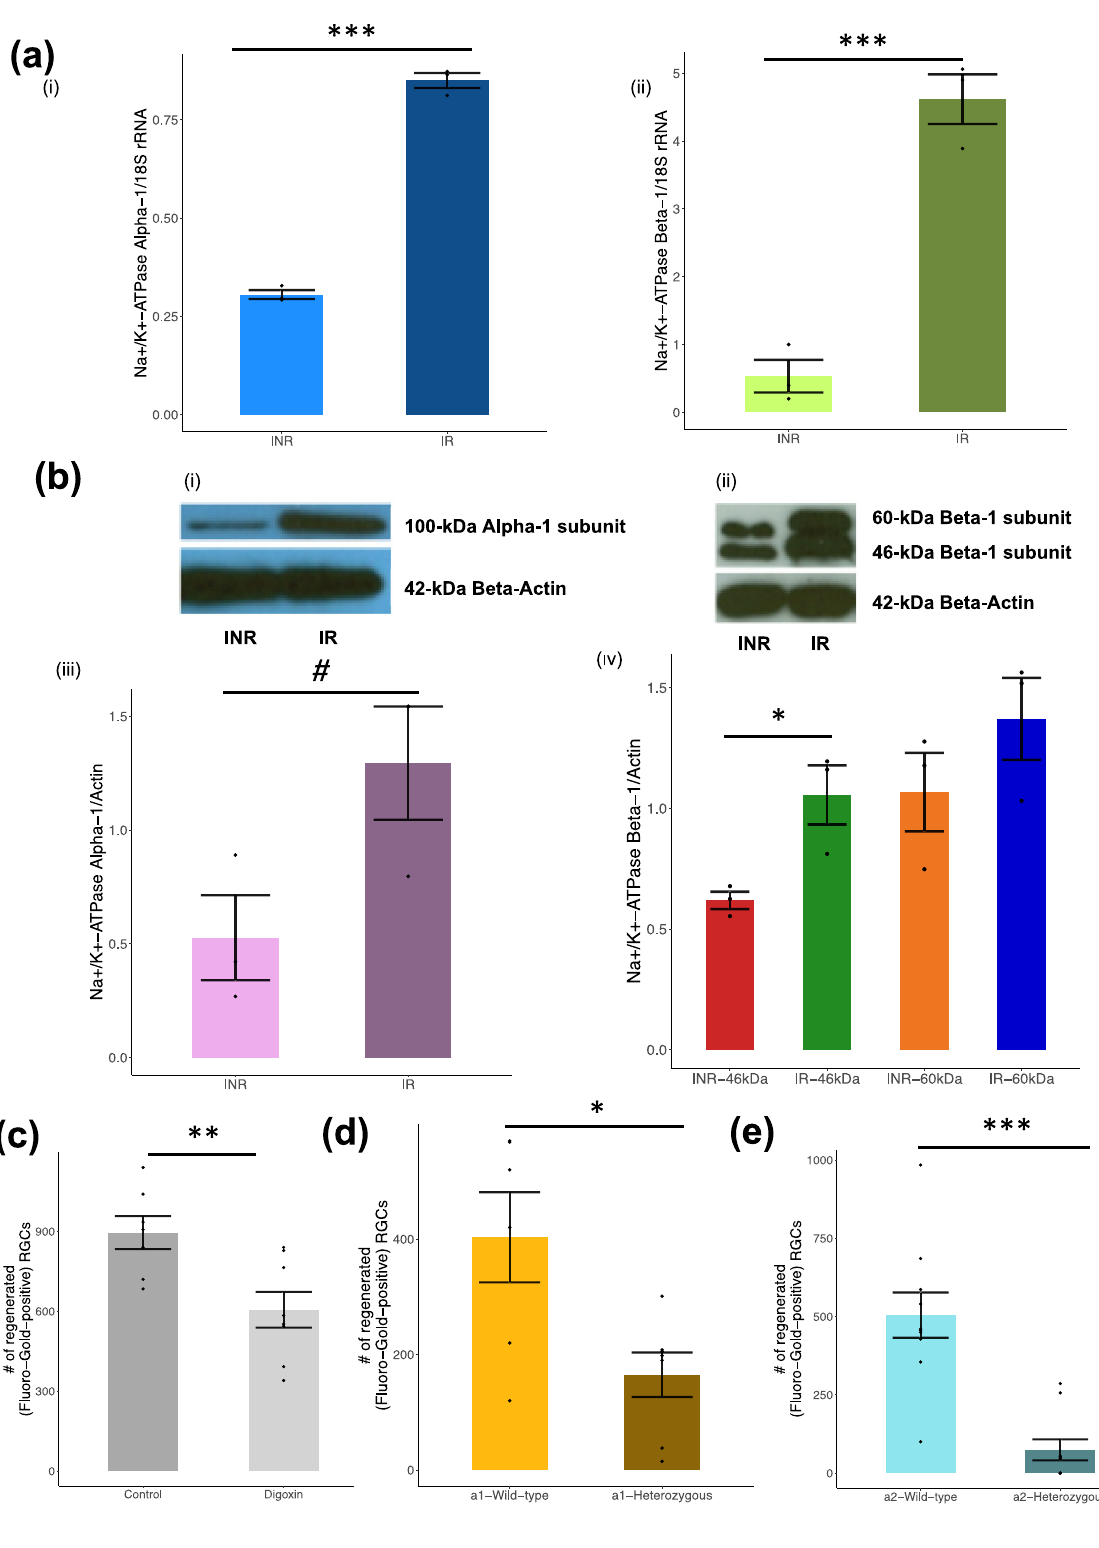
(Fig. 7d), and the α 2 heterozygous knockouts had 74 ± 33.7 ( N = 7) regenerated RGCs compared to 504 ± 72 ( N = 10) in wild-type controls, an 85% reduction (Fig.